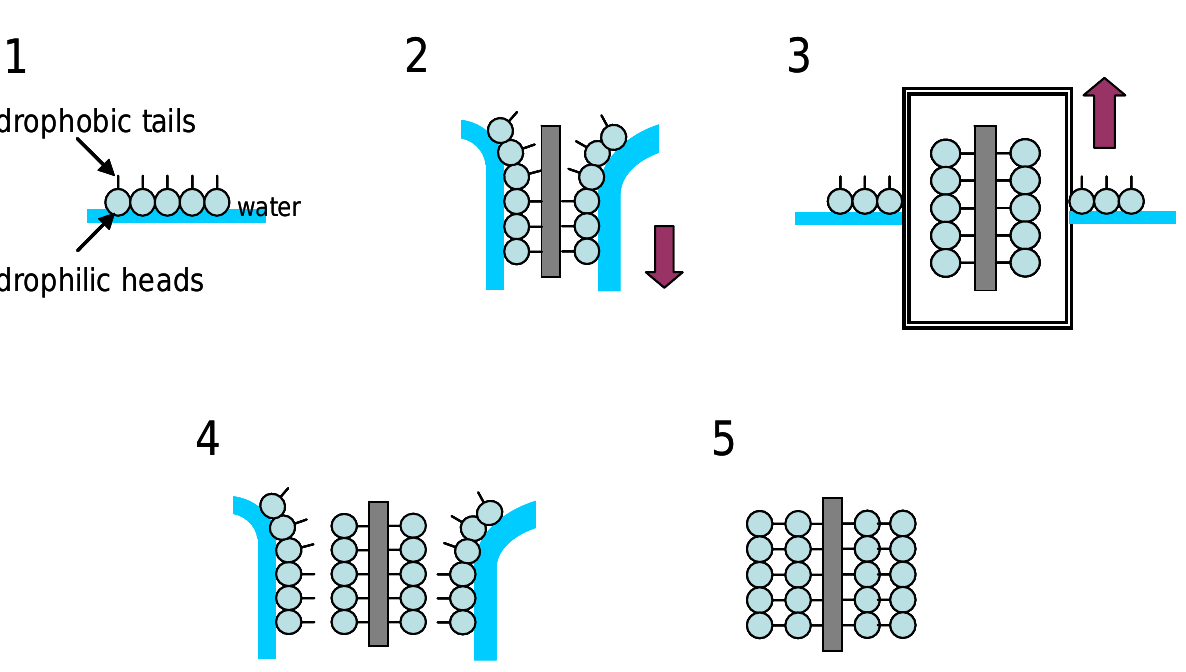
Figure 7. Main construction steps of Langmuir Blodgett deposition technique. This process is very useful when fixing layers onto uniform